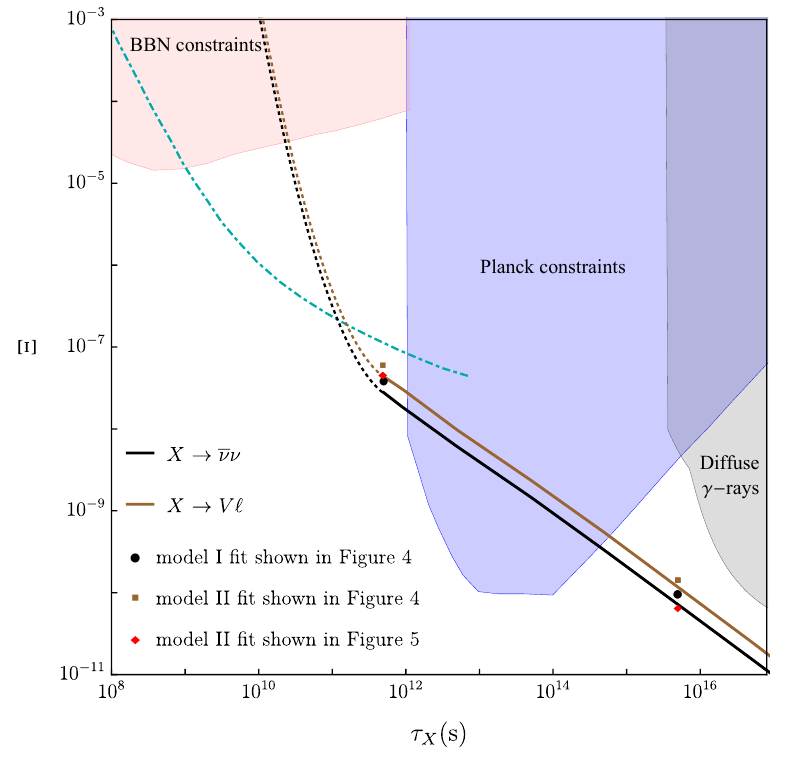
Figure 2 . Constraints on a wide array of di(cid:11)erent lifetimes for a heavy decaying relic X , releasing EM energy into the thermal bath. All constraints are at 95% con(cid:12)dence level. The light red shaded area is excluded by measurements of light element abundances and their agreement with BBN predictions. The blue shaded area is excluded by bounds from CMB anisotropies. The gray shaded region is excluded by di(cid:11)use (cid:13) -ray observations. All of these constraints are for injections of EM energy above some threshold value unique to the constraint and described in their respective sections of this paper. The cyan line is the forecast from the proposed PIXIE experiment, which could place more stringent bounds from y -distortion [55]. The black and brown lines indicate the abundance necessary to produce the excess IceCube neutrinos for models I and II, based o(cid:11) equation (3.15) and (4.1), assuming M X = 2 : 4 (1 + z (cid:28) ) PeV. The black and brown (red) markers X indicate the data points corresponding to the IceCube spectrum shown in (cid:12)gure 4 ((cid:12)gure 5). The dotted lines indicate M X = 2 : 4 (1 + z (cid:28) ) PeV transitioning to an approximation rather than a best X (cid:12)t, as rescattering e(cid:11)ects can change the electromagnetic fraction by O (1). rules out relics that inject enough EM energy at speci(cid:12)c redshifts to produce power spectra inconsistent with current